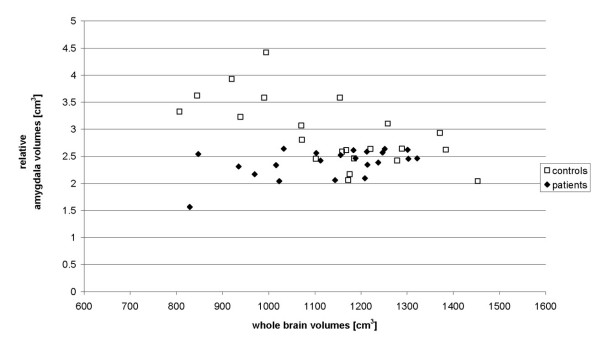
Relative amygdala volumes plotted against total brain volumes in ALS patients and controls.